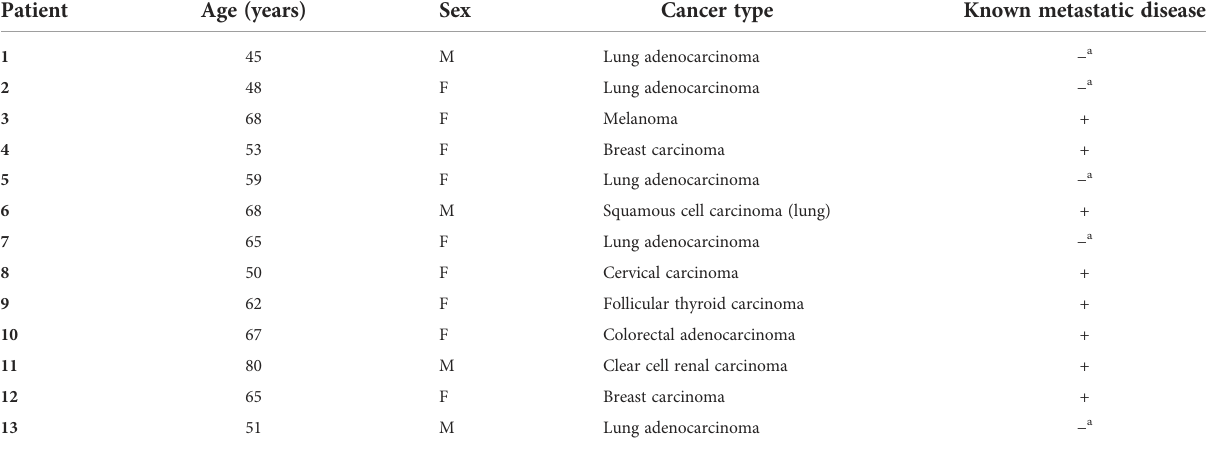
TABLE 1 Patient demographics and primary neoplasm.